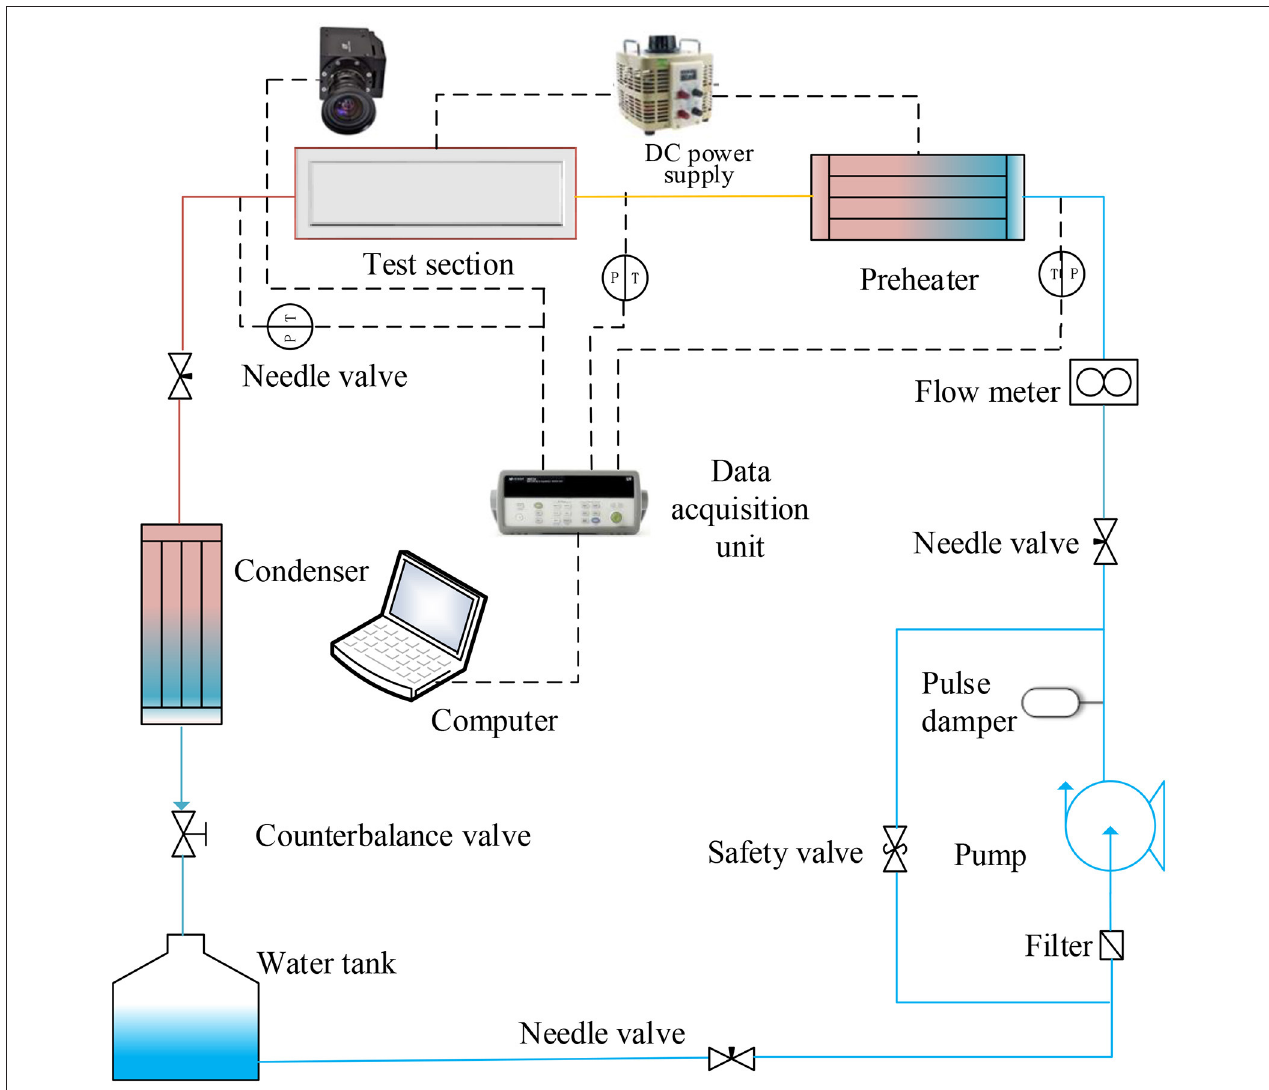
rectangular channel. The two sumps extend 11 mm downward and connected with a circular passage of 8 mm in diameter and 86 mm in length, respectively. In order to facilitate the pipe connection, circular passages with a diameter of 13 mm and a length of 14 mm are machined at the inlet and outlet. At the bottom of the experimental section, there are two slots with a width of 5 mm and a depth of 39 mm near the inlet and outlet, so that the heat of the heated copper block is conducted upward, so as not to affect the liquid temperature measurement of the inlet and outlet. To measure the temperature along the test section, 27 thermocouples, three in each group, arranged right below the rectangular channel. Thirty-six barrel heaters with the diameter of 9 mm are placed in the copper base to provide heat power. The test section is covered with asbestos insulation material in order to minimize the heat